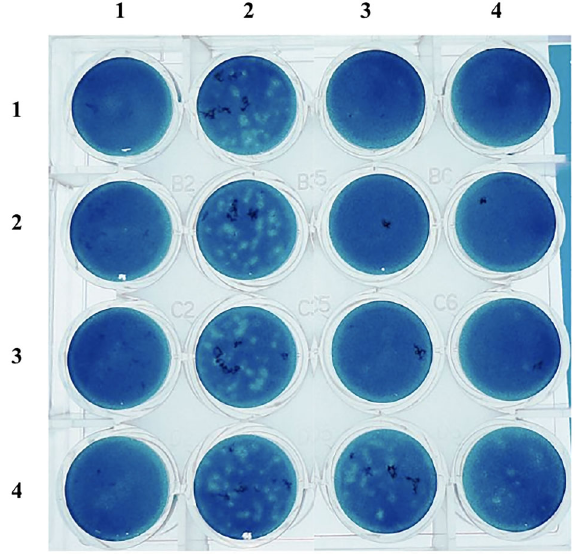
Figure 2. Virucidal assay of the ethanolic extract of Solanum sisymbriifolium roots against dengue virus (DENV-2). DENV-2 ( B 50 PFU) was treated with 10-fold serial dilutions of the root extract and used to infect duplicate Vero E6 cell cultures grown in 24-well plates for 7 days. The extract concentrations used in the assay are as follows: in columns 3 and 4, line 1: 2000 m g/mL; line 2: 200 m g/mL; line 3: 20 m g/mL; and line 4, 2 m g/mL. Uninfected cells (column 1) and cells infected with untreated DENV-2 (column 2) were used as